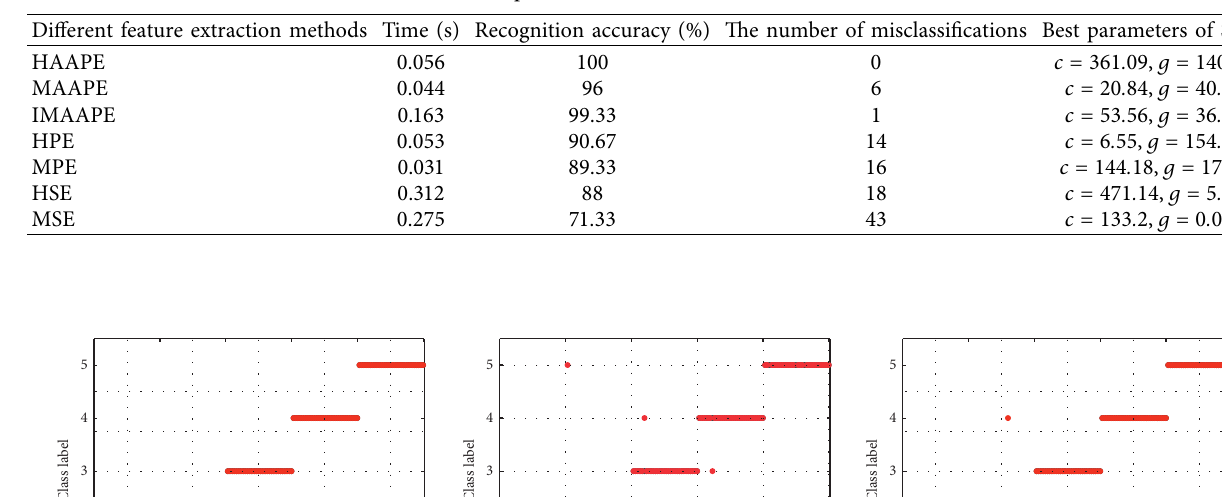
Figure 13: The original feature vectors and the sensitive feature vectors. (a) Original fault features; (b) fault features after Table 6: The comparison of different feature extraction methods.